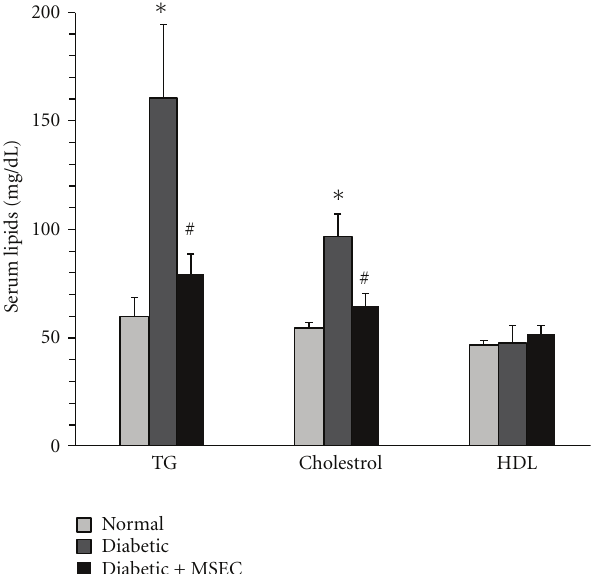
Figure 3: E ff ect of long-term administration of MSEC on the levels of plasma lipids in diabetic rats. The animals in group of diabetic + MSEC received diet containing 4% (w/w) of MSEC for 1 month. ∗ P < 0 . 01 versus normal rats. # P < 0 . 05 versus diabetic group. The data are expressed as mean ± SEM for eight (normal and diabetic + MSEC groups) or six (diabetic groups) rats. MSEC: combination of both macerated and Soxhlet extracts; TG: triglycerides; TC: total cholesterol; HDL: high-density lipoprotein.